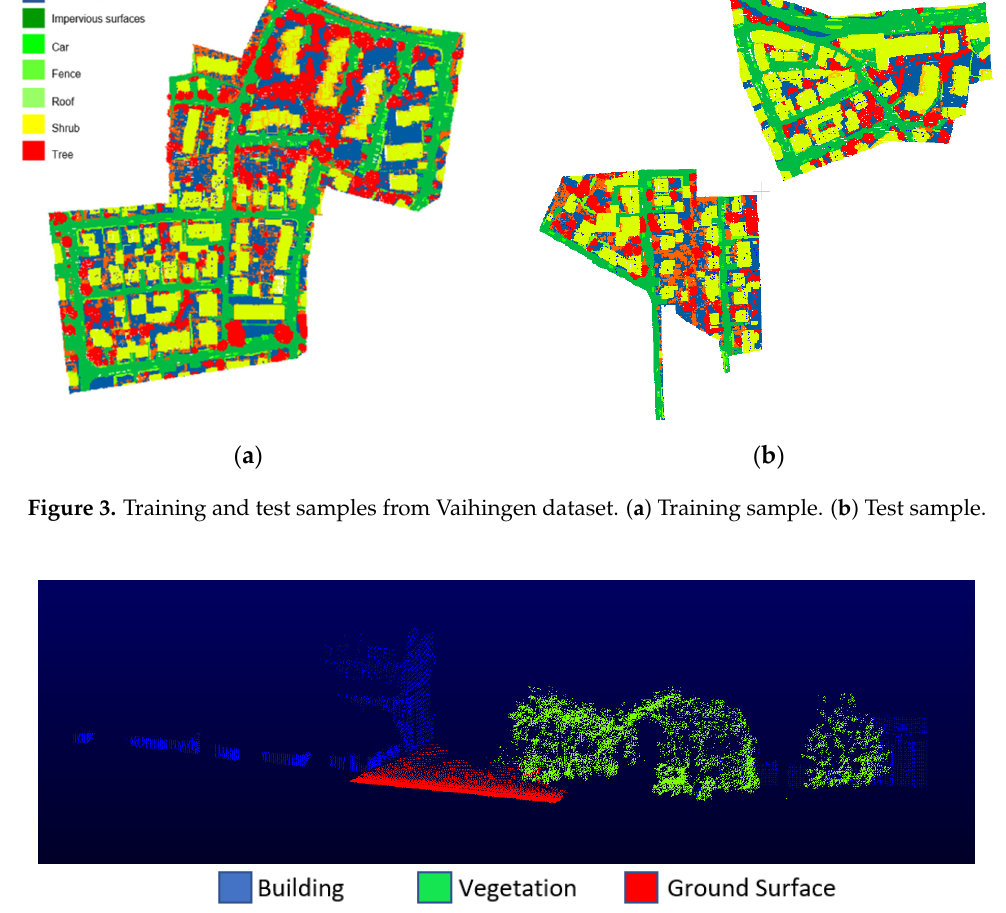
Figure 4. Training samples from the Oakland dataset.